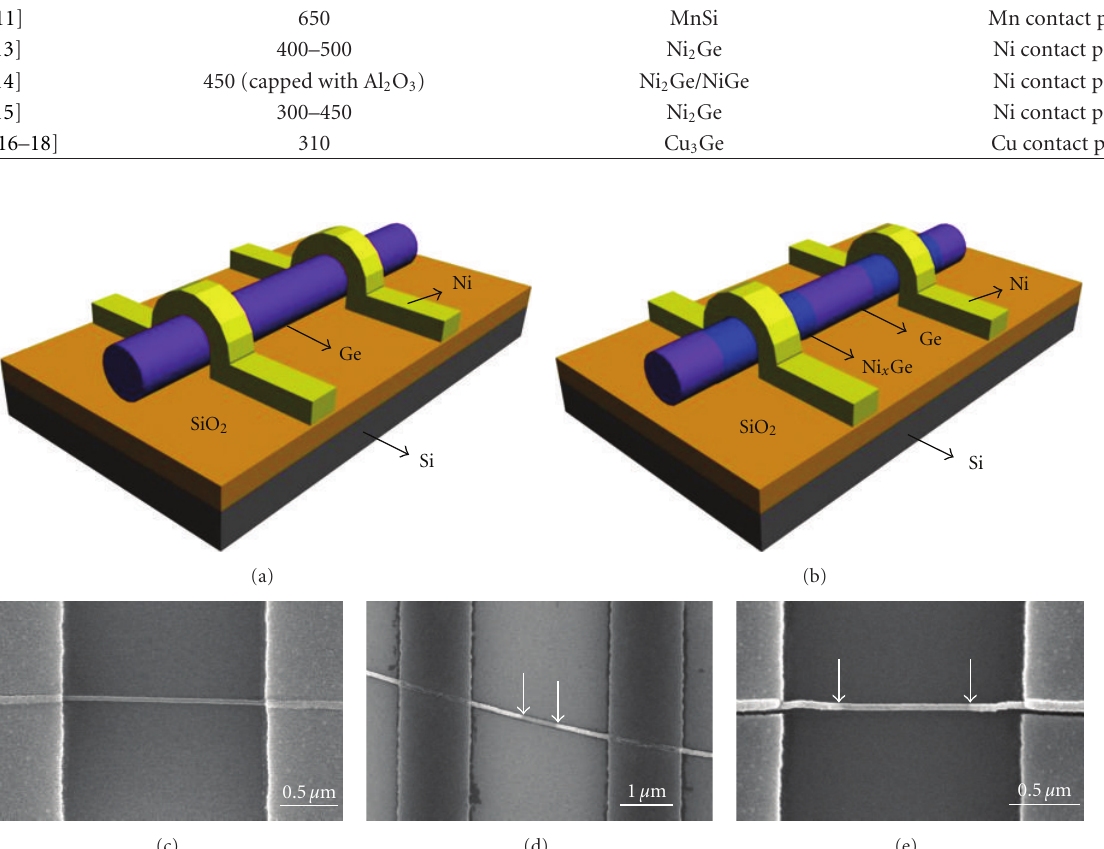
Figure 1: Formation of Ni 2 Ge/Ge/Ni 2 Ge heterostructures. Schematic illustration showing (a) before and (b) after the di ff usion process of Ni into the Ge nanowire forming a Ni 2 Ge/Ge/Ni 2 Ge heterostructure. (c) SEM image of the Ge nanowire device with EBL defined Ni electrodes. (d) SEM image of the Ni 2 Ge/Ge/Ni 2 Ge heterostructure after RTA at 500 ◦ C for 60s in which the length of the Ge region was easily controlled to submicron range. The arrows indicate the growth tips of the Ni 2 Ge nanowire. (e) SEM image of the Ni 2 Ge/Ge/Ni 2 Ge heterostructure after RTA at 400 ◦ C for 40s. The arrows indicate the growth tips of the Ni 2 Ge nanowire. Reproduced from [13].